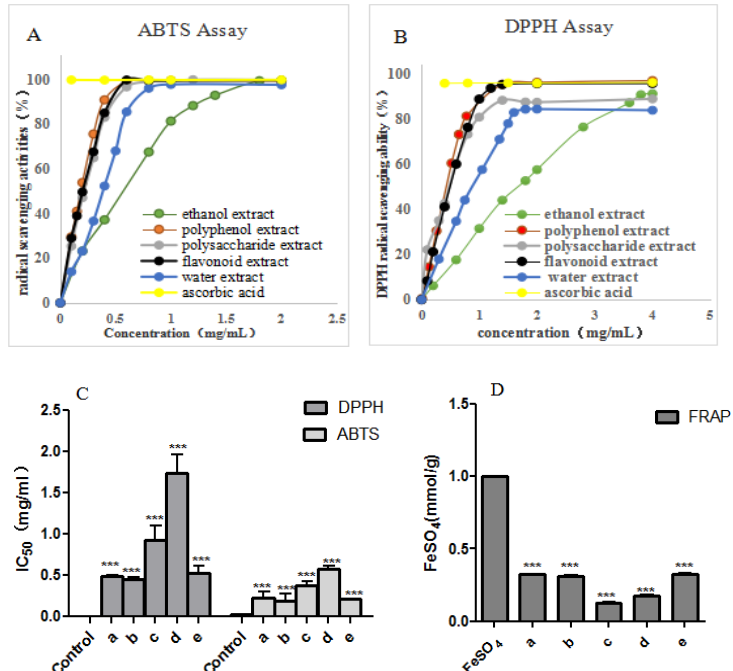
Figure 3. ( A ) ABTS radical scavenging curve of five extracts. ( B ) DPPH radical scavenging curve of five extracts. ( C ) IC 50 (mg/mL) for ABTS and DPPH free radical scavenging of five extracts. ( D ) FRAP value (mmol/g Fe 2+ ) of various extracts of F. tikoua fruit. Each bar was replicated three times, with statistical significance defined as p < 0.05 (*** p < 0.001) vs. control. a = polysaccharide extract; b = polyphenol extract; c = water extract; d = ethanol extract; e = flavonoid extract.